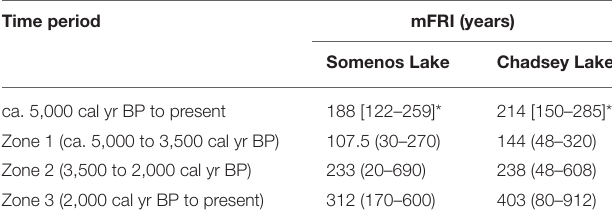
TABLE 2 | Mean fire return intervals (mFRI) for Somenos and Chadsey